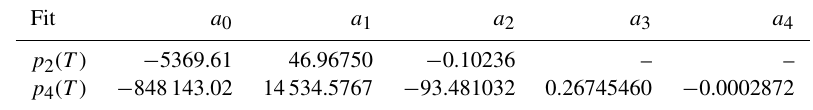
Table C1. Coefficients for the polynomial fits of the nucleation rate by Koop and Murray (2016) as given in Eq. (C2).